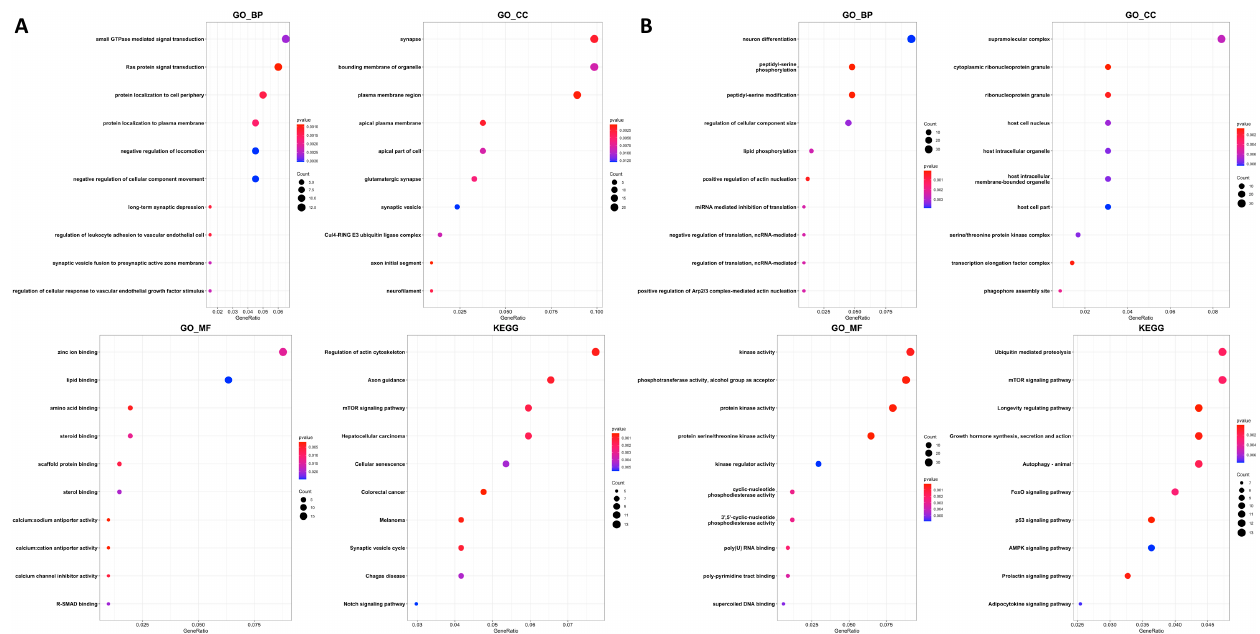
Figure 3. Enrichment analysis for GO_BP, GO_CC, GO_MF, and KEGG. GO_BP: Biological processing; logical pathway. ( A ) BCMT-T vs. BCMT-N; ( B ) MCMT-T vs. MCMT-N.